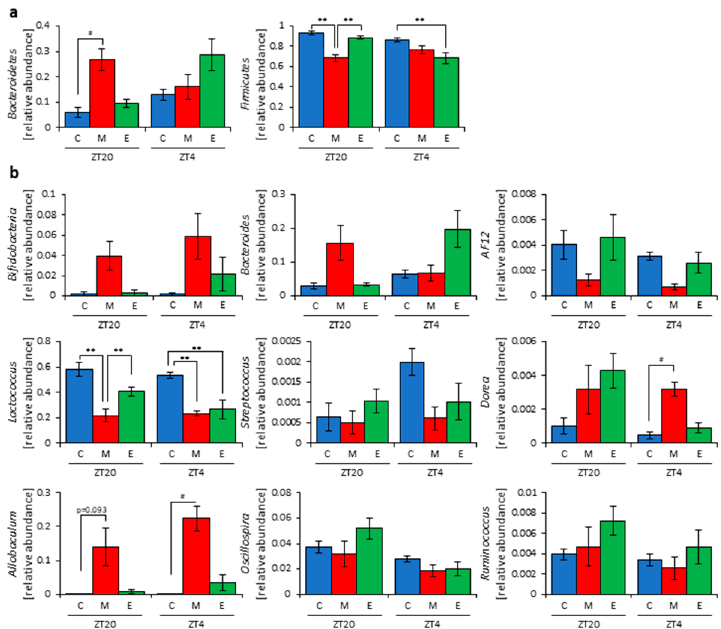
Figure 4. Morning inulin feeding changed the relative abundance of some bacteria. ( a ) Phylum level. ( b ) Genus level. All values are represented as mean ± SEM (cellulose at ZT20 (n = 5) and 4 (n = 5); morning inulin at ZT20 (n = 5) and 4 (n = 5); evening inulin at ZT20 (n = 5) and 4 (n = 5)). ** p < 0.01, evaluated using the two-way ANOVA with Tukey’s post hoc test. # p < 0.05, evaluated using the Kruskal–Wallis test with Dunn post hoc test with a two-stage linear step-up procedure of the Benjamini, Krieger, and Yekutieli test for multiple comparisons. Cellulose, morning inulin, and evening inulin are C, M, or E, respectively.